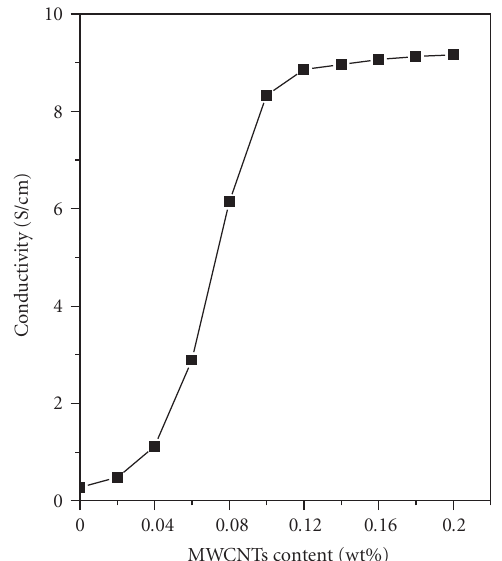
Figure 6: The electrical conductivity of composite films as a function of weight fraction of